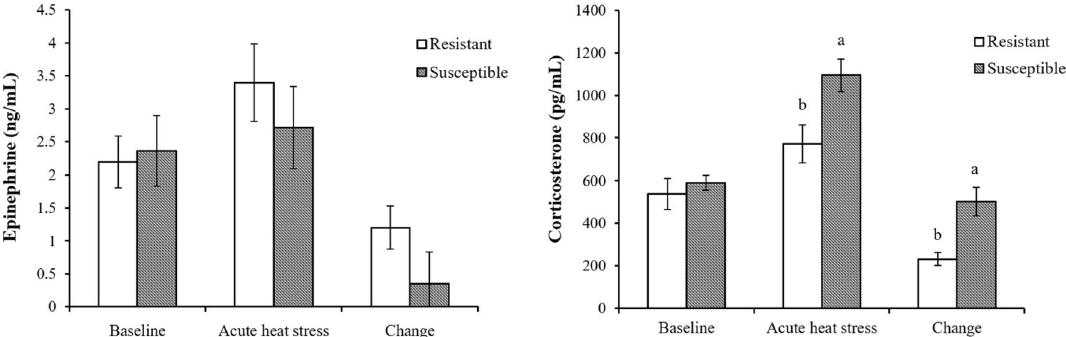
Figure 5. Plasma epinephrine and corticosterone concentrations of male L2 strain TCCs before and after acute heat stress. Results are expressed as mean ± standard error (n = 5). a,b Superscripts indicate a difference between groups ( P < 0.05).